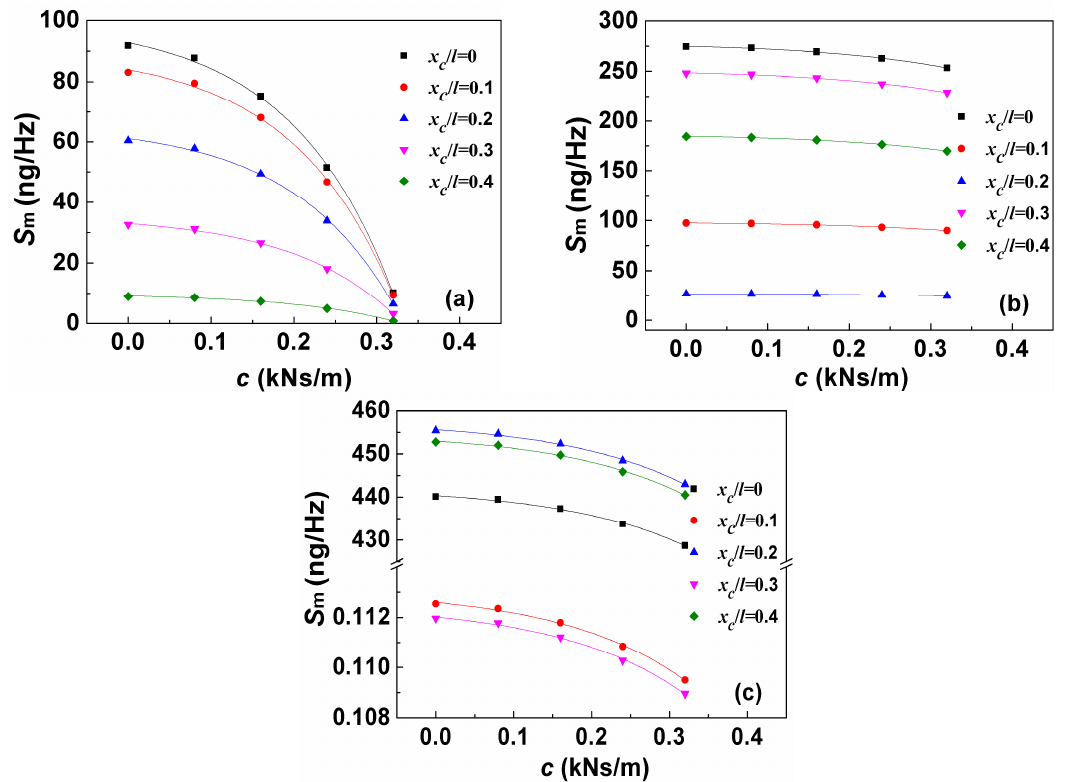
Figure 6. S m as the function of viscous damping coefficient c for different loading positions under: ( a ) first-order resonance; ( b ) third-order resonance; and ( c ) fifth-order resonance.